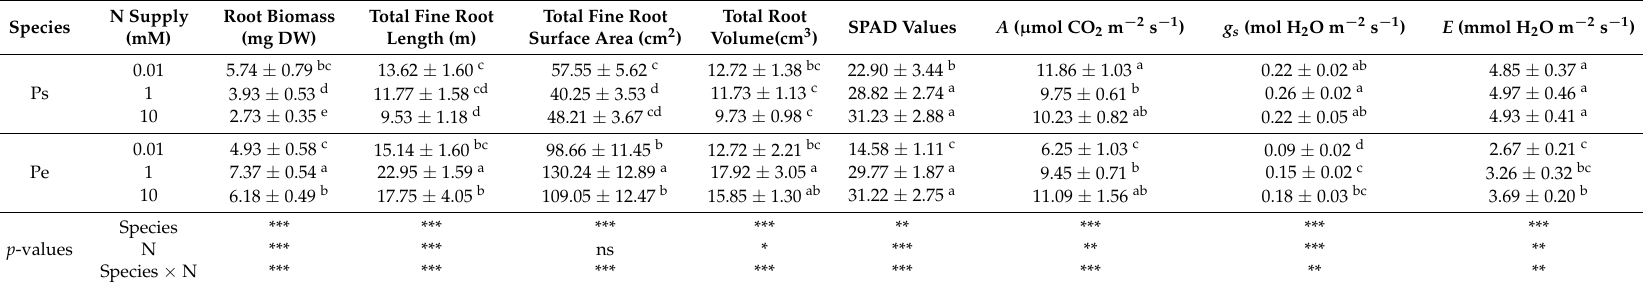
Table 1. Growth and photosynthetic characteristics of slow growing P. simonii (Ps) and fast growing Populus × euramericana (Pe) plants exposed to 0.01, 1, or 10 mM NH 4 NO 3